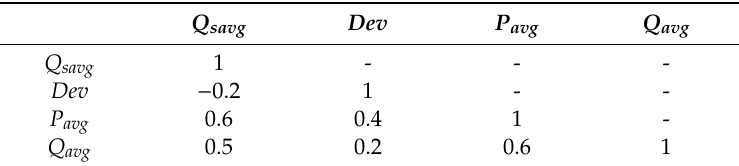
Table 3. Correlation coefficient among variables.